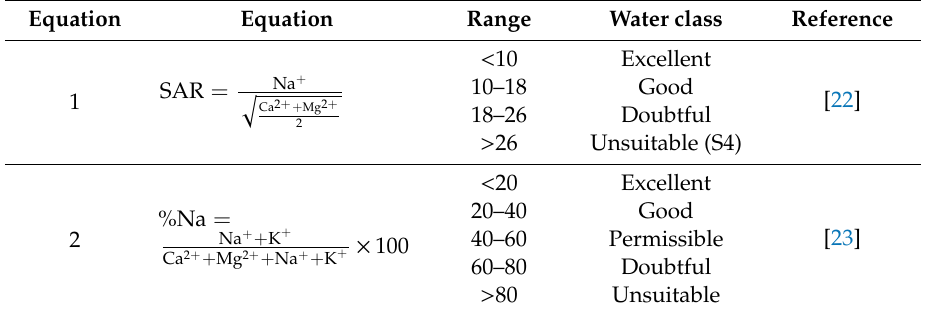
Table 2. Equations used for calculating sodium adsorption ratio (SAR) and % Na.